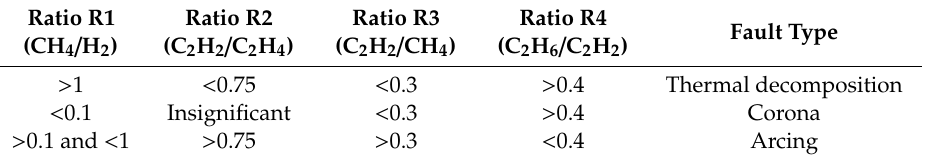
Table 2. Fault diagnosis by the Dornenburg ratio method.